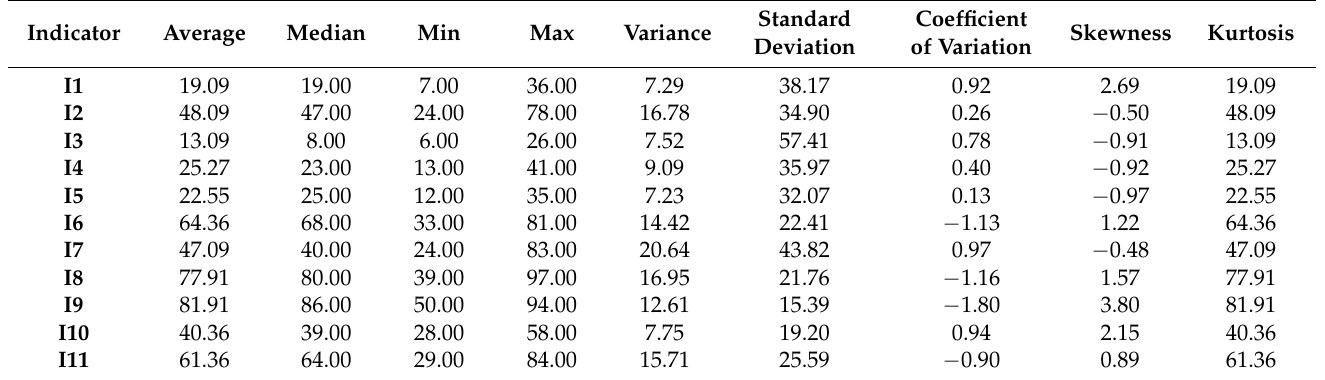
Table 6. Basic descriptive statistics of indicators for large enterprises in the CEE